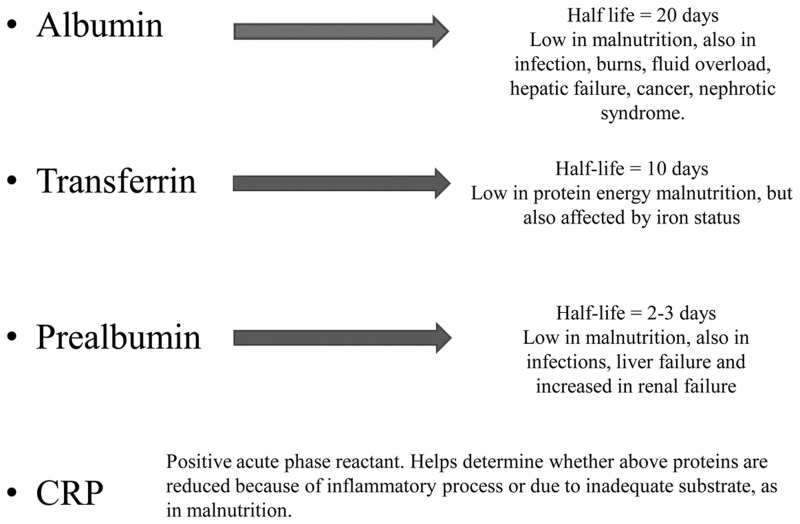
 Laboratory markers